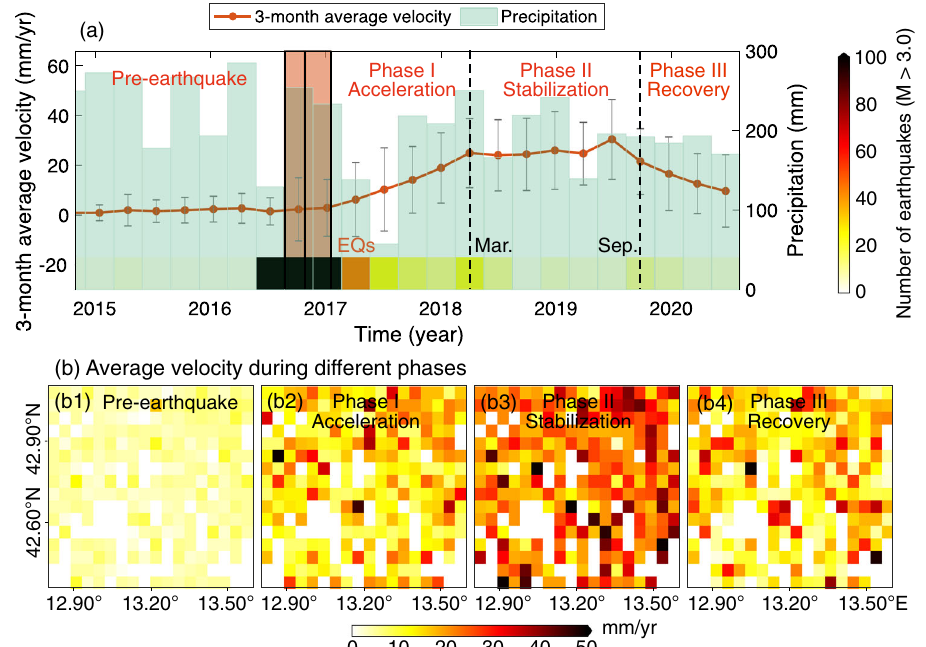
Fig. 4 | Average velocity of Earthquake Accelerated Landslides (EALs) in the study area estimated every three months. a Times series of the 3-month mean velocity and corresponding precipitation. The red shading indicates the period of the 2016-2017 earthquake sequence, and the black vertical solid lines indicate the speci fi c time of the four earthquakes. The colored rectangles at the bottom of ( a )